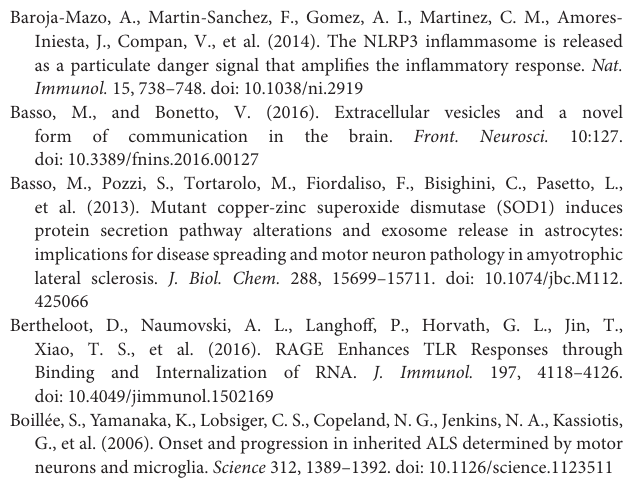
Table S 1 | List of primer sequences used in qRT-PCR. (A) Primers used in gene expression. (B) Primers used in microRNA